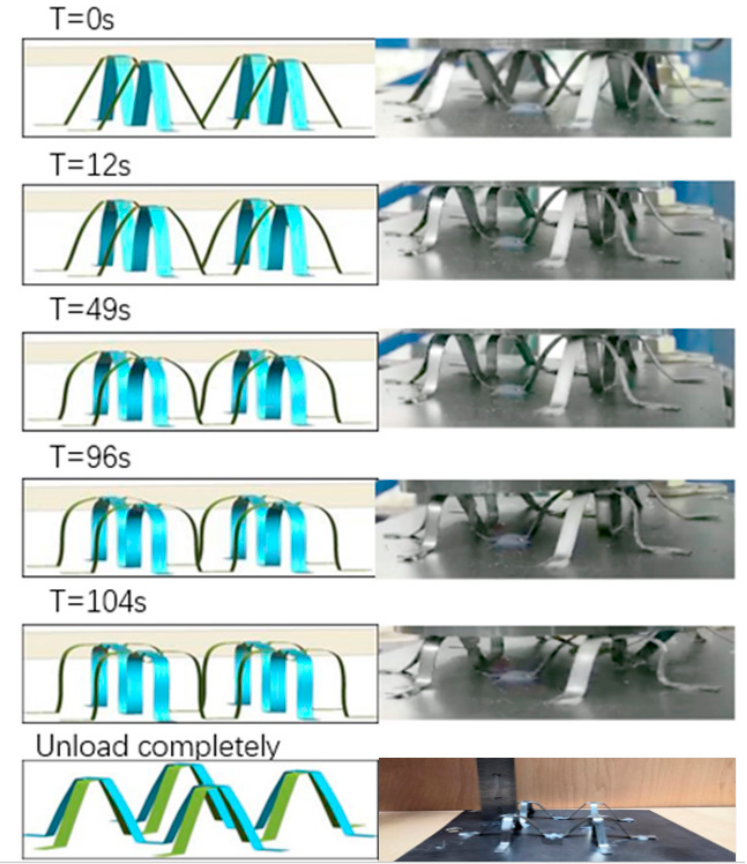
Figure 8. Comparison of simulation and experiment loading procedure of NiTi memory alloy assembly module.